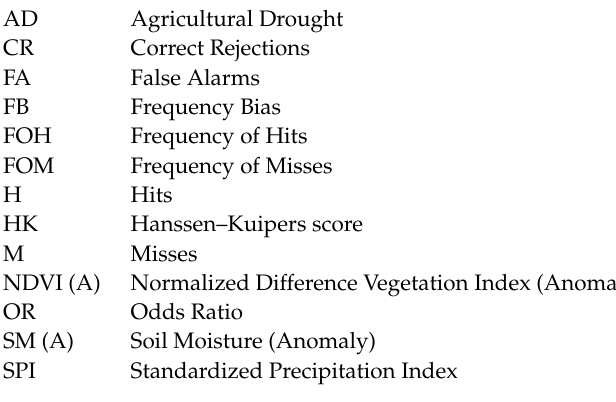
Figure S8: Skill score analysis with a one month lag. Figures S9–S12: Average time series of soil moisture (anomalies) and NDVI (anomalies) prior to and during the drought